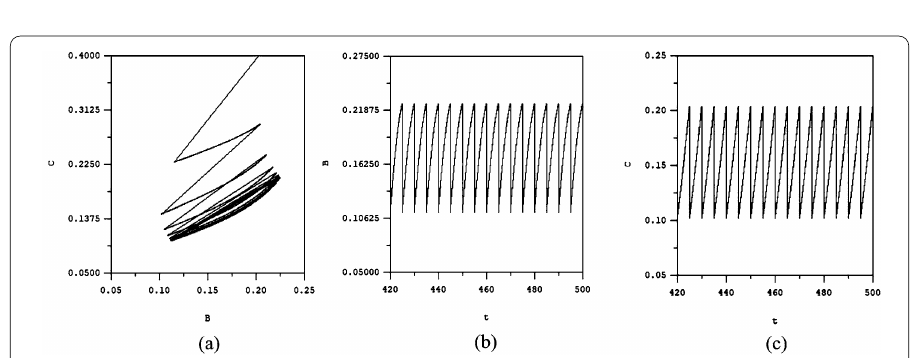
Figure 2 A computer simulation of Eqs. (1a)–(1d). The solution of the system is permanent. Here, a 1 = 0.5, a 2 = 0.7, b 1 = 0.5, r 1 = 0.9, d 1 = 0.01, d 2 = 0.1, h 1 = 3, h 2 = 5, h 3 = 0.2, α = 0.2, β = 0.2, T = 10, B (0) = 5, and C (0) = 5. Here, all conditions in Theorem 2 are satisfied. ( a ) The solution trajectory projected on the ( B , C )-plane. ( b ) The bounded time series of the population density of brown planthoppers ( B ). ( c ) The bounded time series of the population density of Cyrtorhinuslividipennis ( C )